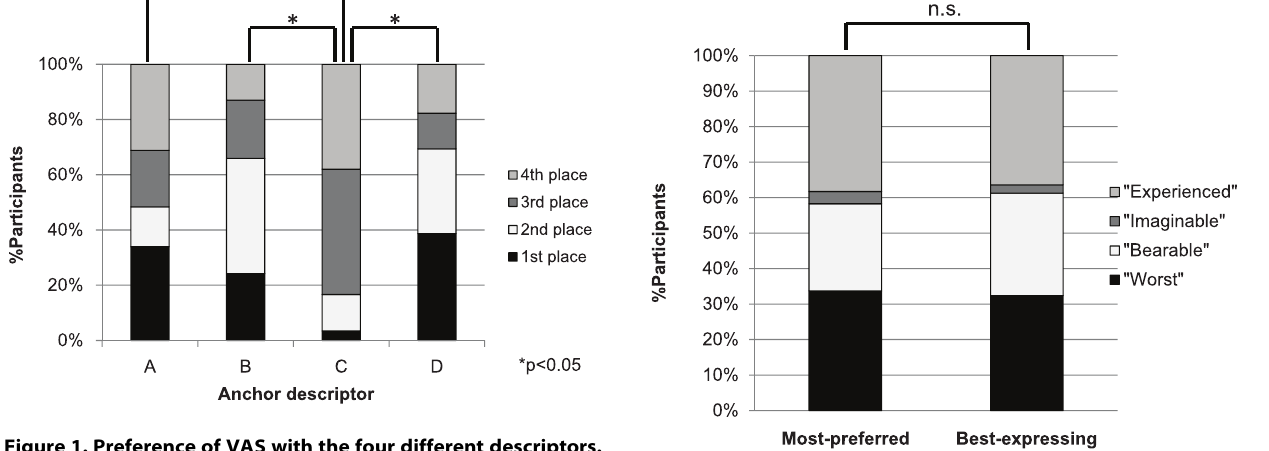
Figure 1. Preference of VAS with the four different descriptors. Friedman test demonstrated a significant difference between the four